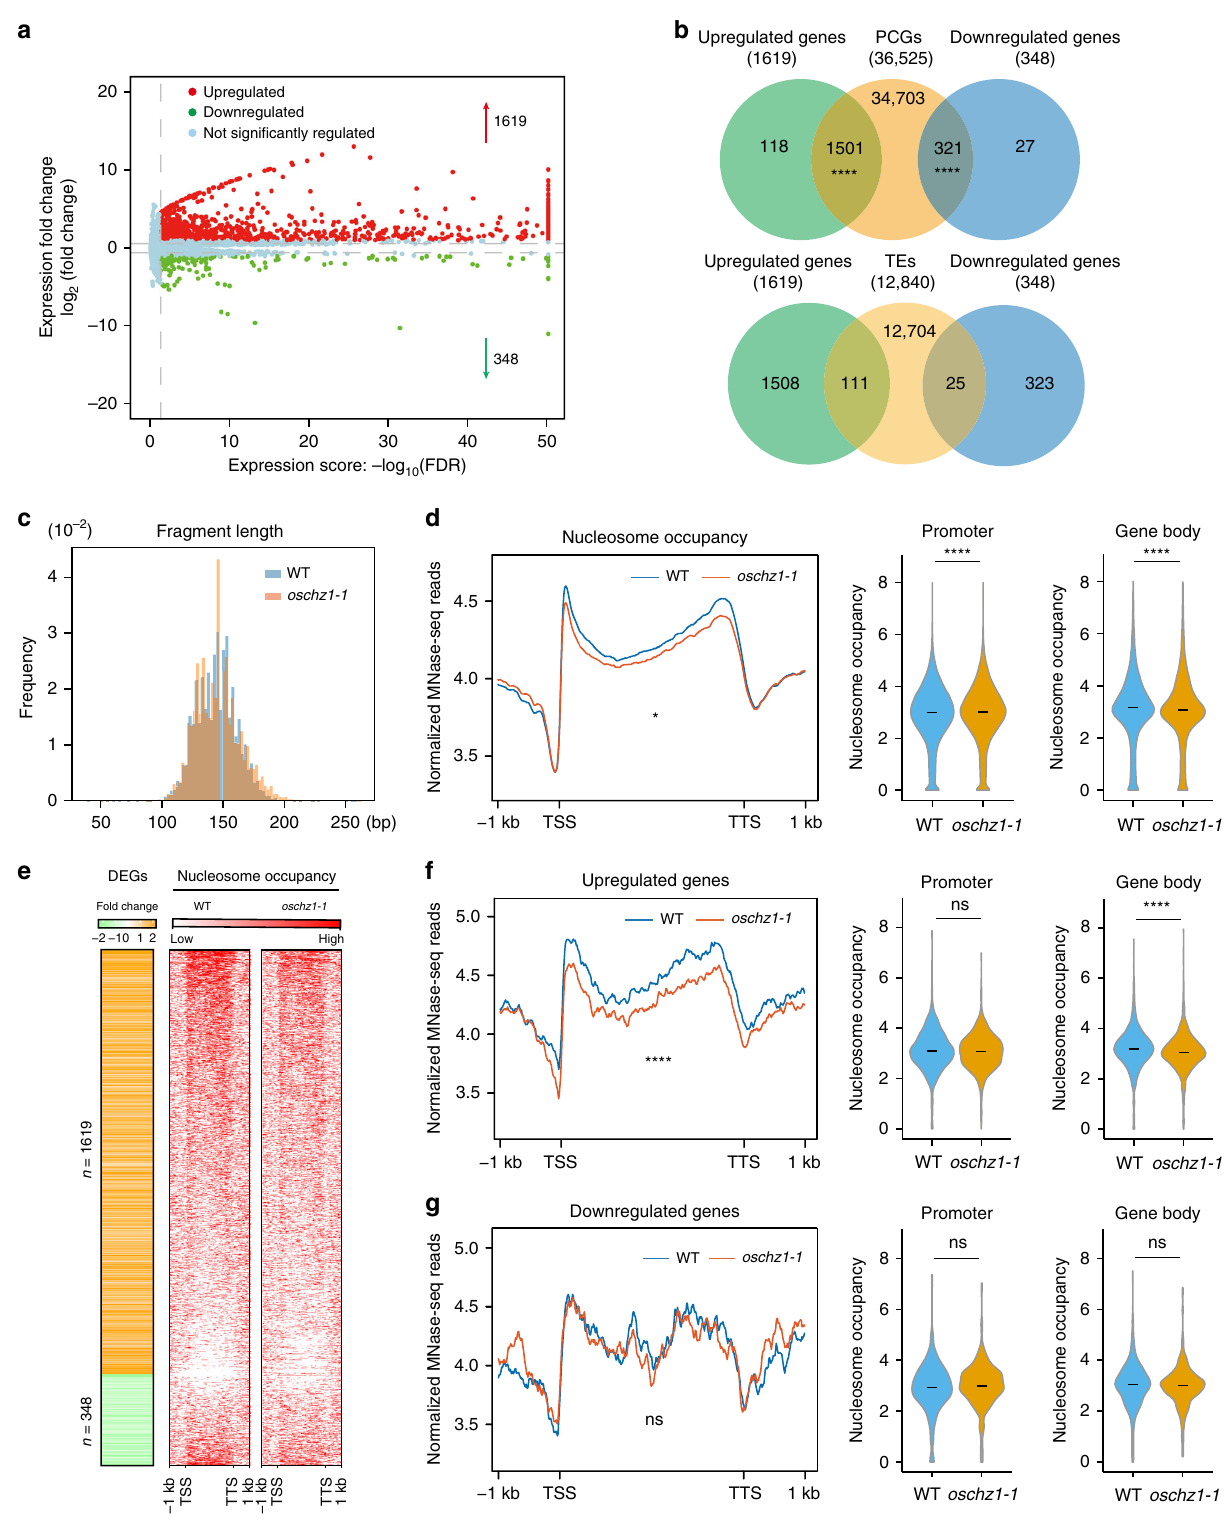
number of misregulated protein-coding genes involved in these different key processes are consistent with the pleiotropic growth and developmental phenotypes of the oschz1 mutants. To gain insight into the mechanisms underlying misregulation of genome transcription, we performed an MNase digestion assay on chromatin (Supplementary Fig. 10c) and investigated nucleo- some distribution in WT and oschz1-1 by MNase-seq analysis.